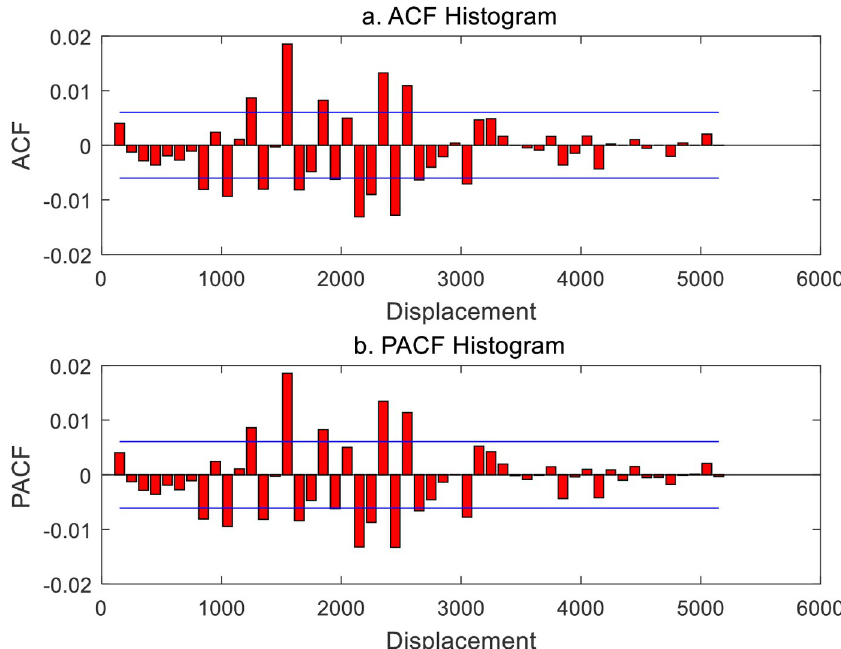
Fig 4. Spatial autocorrelation function and partial autocorrelation function of Chinese cities based on conventional Moran’s index and correlation density (2000).